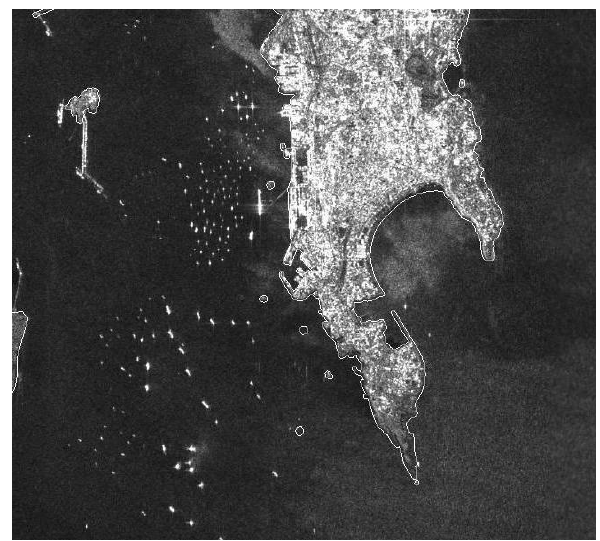
Fig 1. Jawaharlal Port, Mumbai (west coast of India). The white bright spots in the black background (sea) depict marine